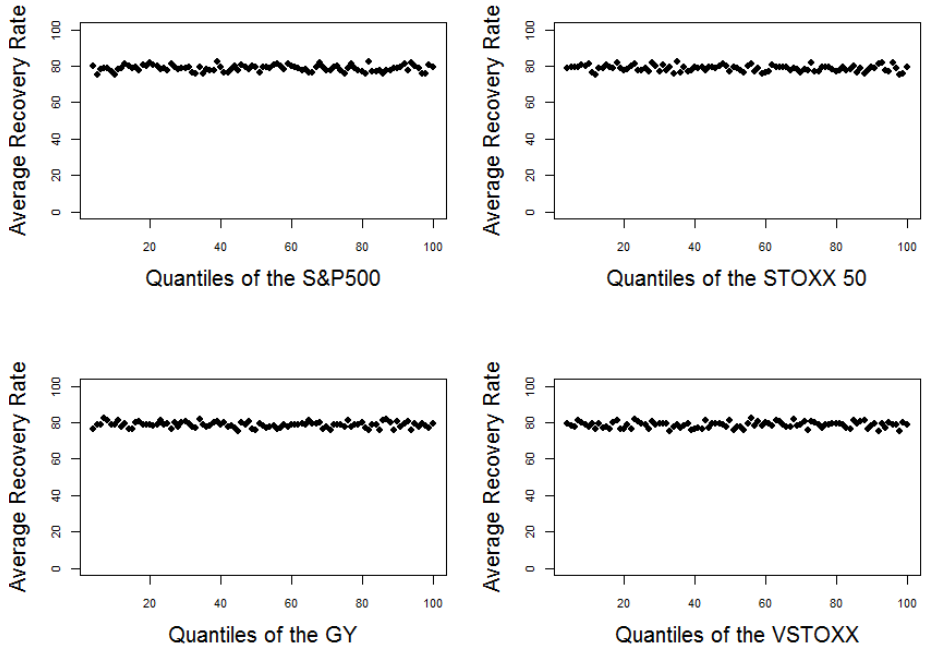
Figure 4. Average recovery rates computed for every percentile of S&P500 ( top left ), STOXX 50 ( top right ), GY ( bottom left ) and VSTOXX ( bottom right